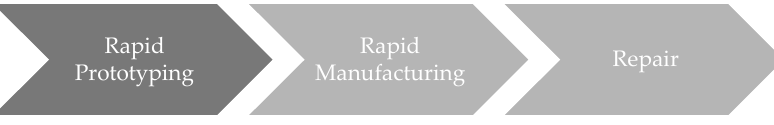
Figure 2. Additive manufacturing (AM) implementation course Figure 2 . Additive manufacturing (AM) implementation course